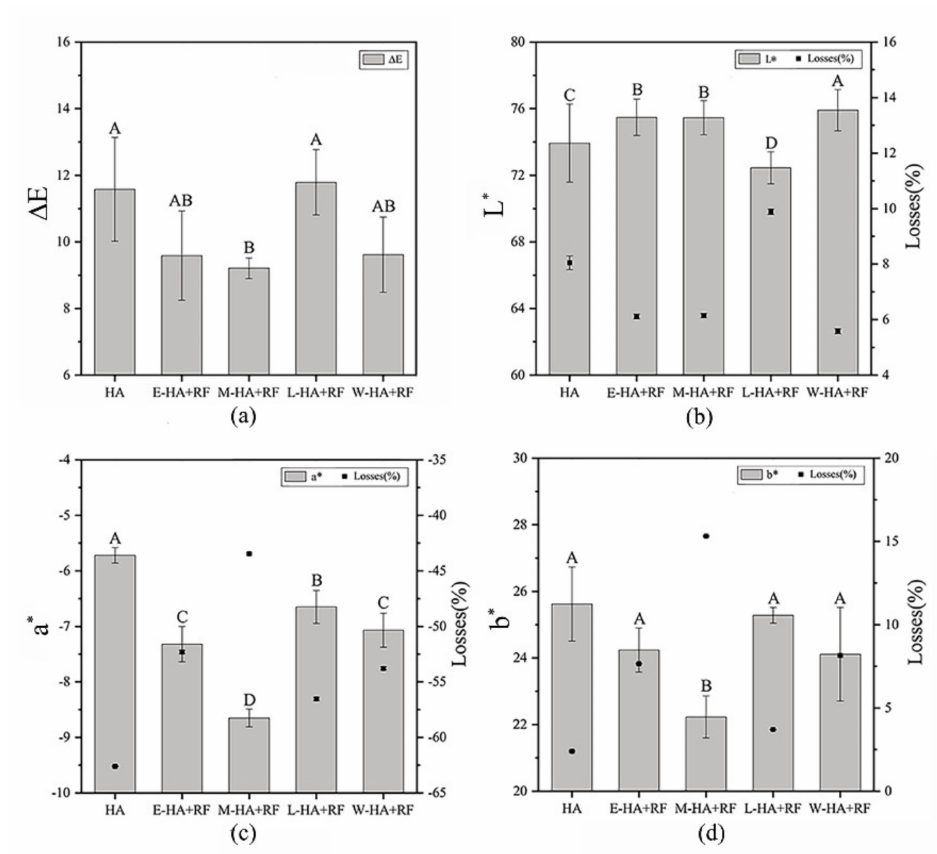
Figure 9. Visual color characteristics of dried jujube slices: ( a ) ∆ E , ( b ) L *, ( c ) a *, and ( d ) b * values. The same letter above the bars indicates that there is no significant difference between the data, and different letters above the bars indicates that there is significant difference between the